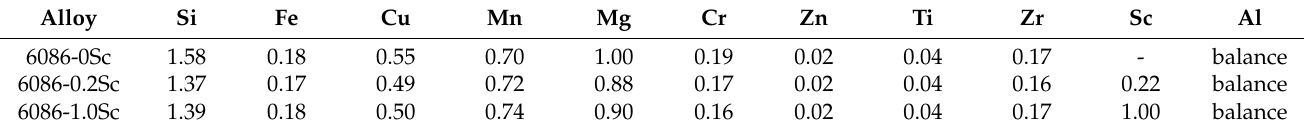
Table 1. The chemical compositions of the investigated alloys in wt.% as determined using AES- ICP (atomic emission spectroscopy—inductively coupled plasma optical emission